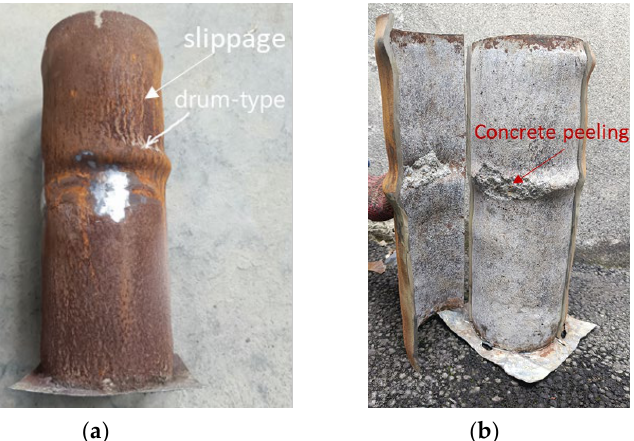
Figure 9. Failure modes of the GCFST-10 specimen under axial compression: ( a ) surface damage; ( b ) fracture inside the specimen. ( b ) fracture inside the